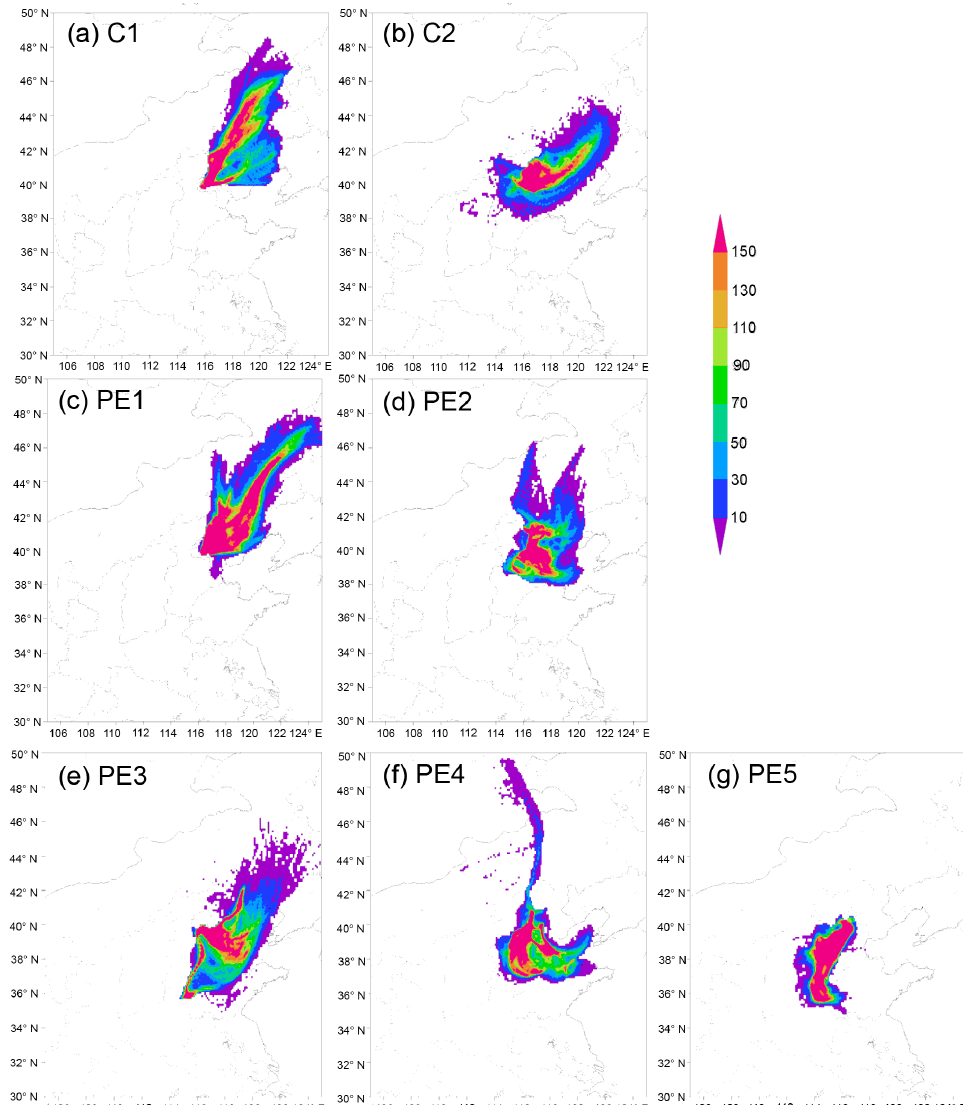
Figure 10. Footprint regions of two clean periods and five pollution episodes that are marked in Fig. 6. The color bar indicates the number concentrations of tracer